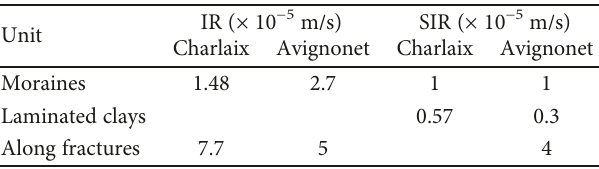
Figure 11: Synthetic geological and geotechnical cross section and conceptual model for water in fi ltration. The shear surface in red corresponds to the shear surface above which the deepest water table is studied in this work. Table 3: Hydraulic properties measured on the study site and comparison with the Avignonet landslide [36, 56]. IR: in fi ltration rate; SIR: saturated in fi ltration rate after Beerkan tests